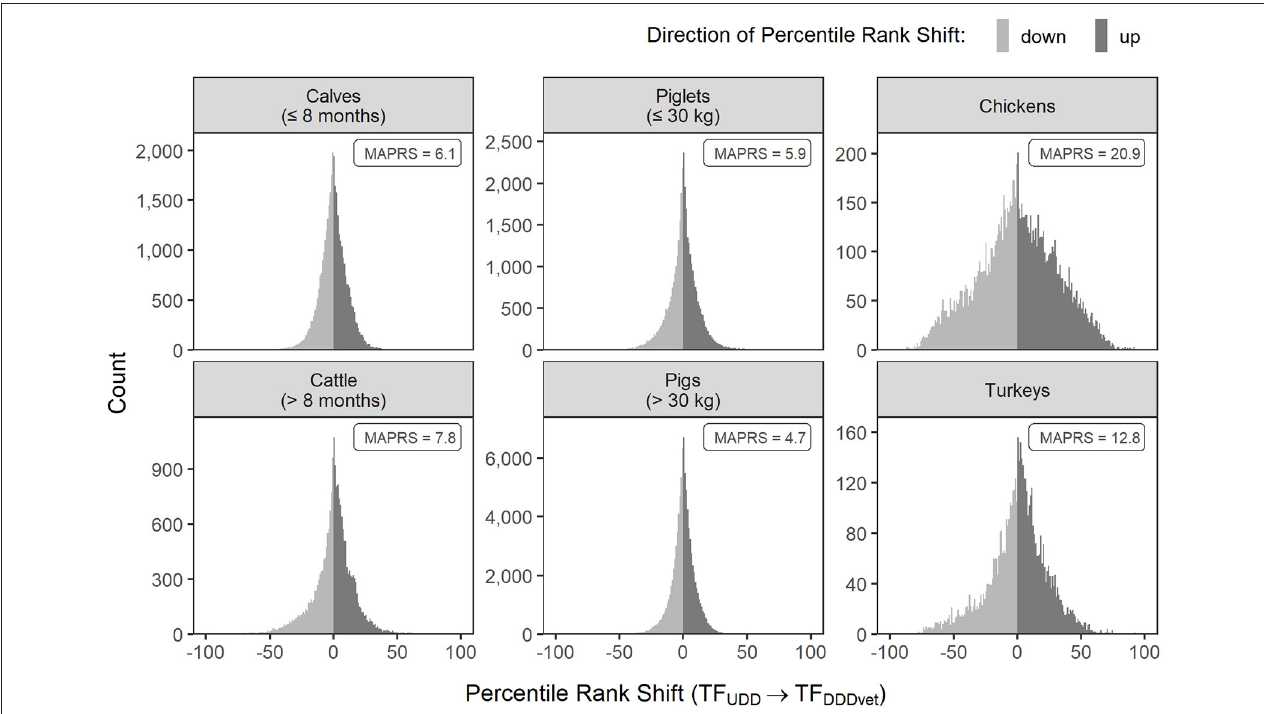
FIGURE 4 | Shift in percentile ranks if farms were ranked by DDDvet-based treatment frequencies (TF DDDvet ) instead of UDD-based treatment frequencies (TF UDD ) for each of the six animal populations covered by the German benchmarking system. Note that the count axis in each panel is scaled individually. Data is from all half-year periods 2014-2 to 2017-2. MAPRS, median absolute percentile rank